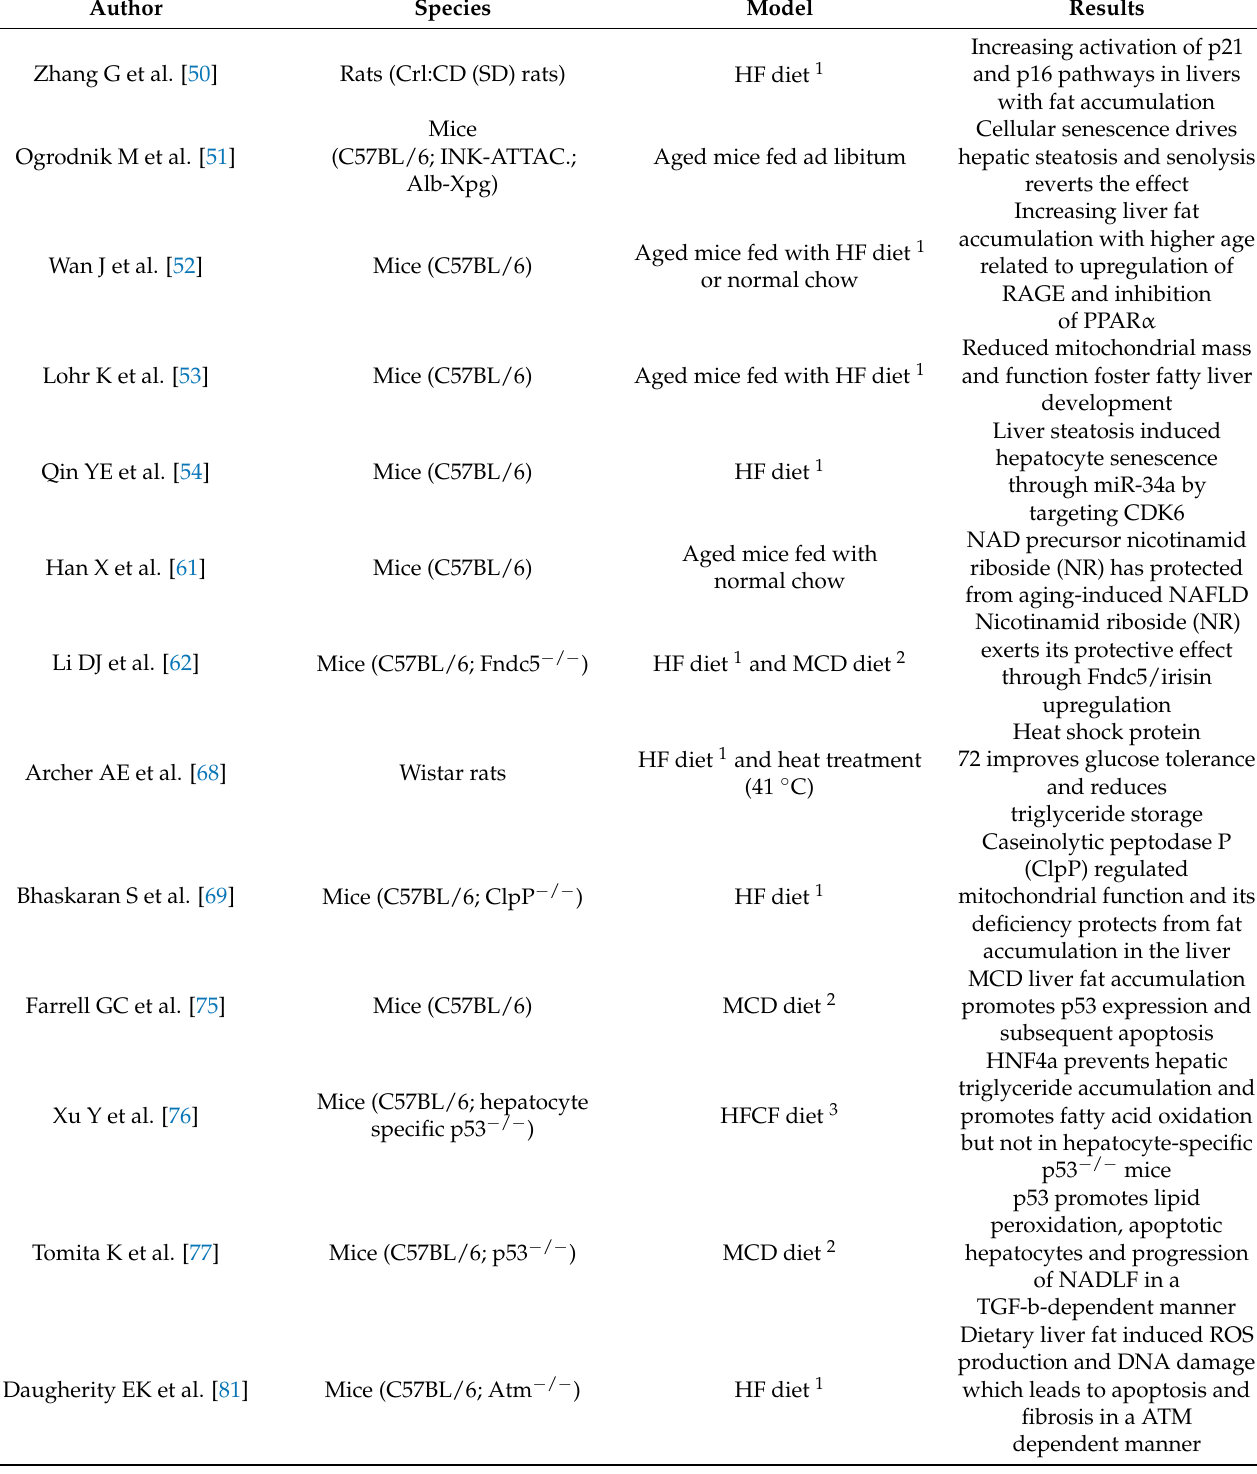
Table 2. Preclinical in vivo studies exploring mechanisms of senescence in fatty liver